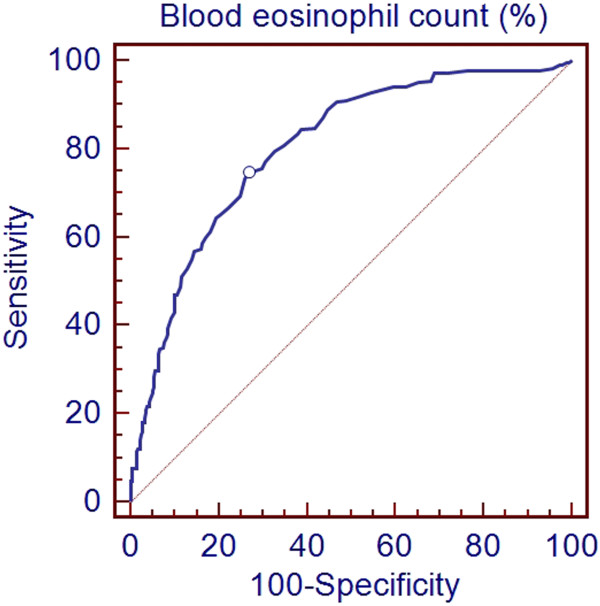
Receiver-operating characteristic (ROC) curve to determine the blood eosinophil count percentage that best identified a sputum eosinophilia ≥3%. The optimum cut-off point was 3% (Sensitivity: 75%, specificity: 73.4%, AUC: 0.81, p < 0.0001).